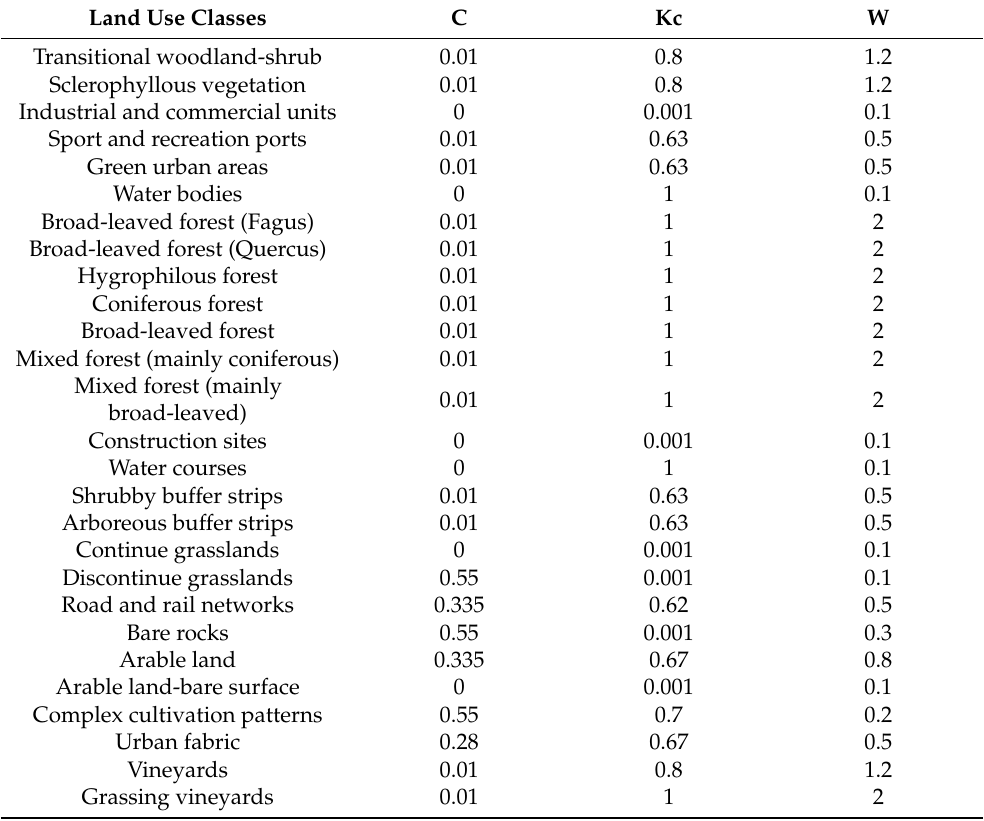
Table 2. Parameters used for evaluation of soil loss by erosion and the real